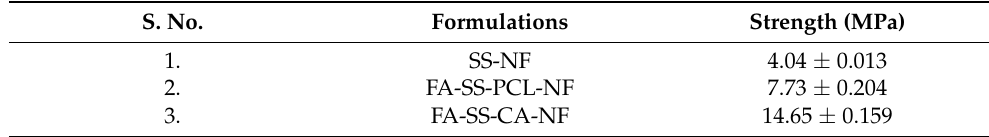
Figure 1. SEM images of nanofibers and their average diameters: ( A ) SS-NF; ( B , C ) FA-SS-PCL-NF; ( D , E ) FA-SS-CA-NF. Table 2. Average tensile strength of